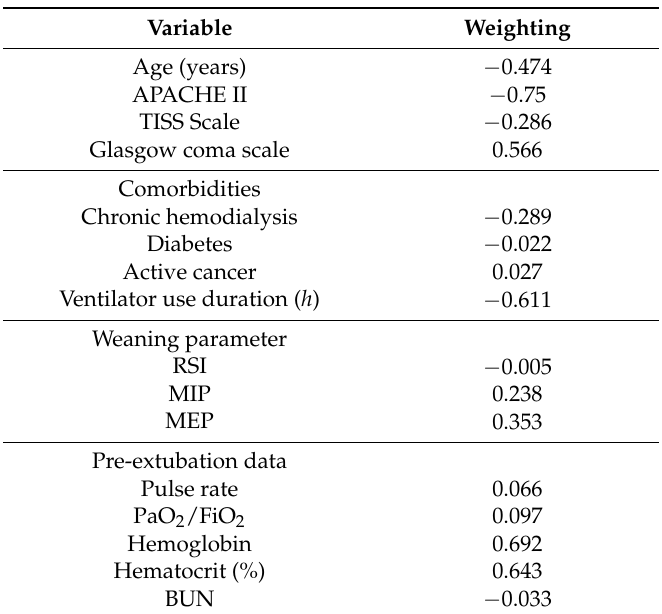
Figure 1. Receiver operating characteristic curve of artificial neural network (ANN), Therapeutic Intervention Scoring System (TISS), maximum expiratory pressure (MEP), and rapid shallow breathing index (RSI) for predicting successful weaning in ICU patients. Table 4. Weighing of each variable in the composite